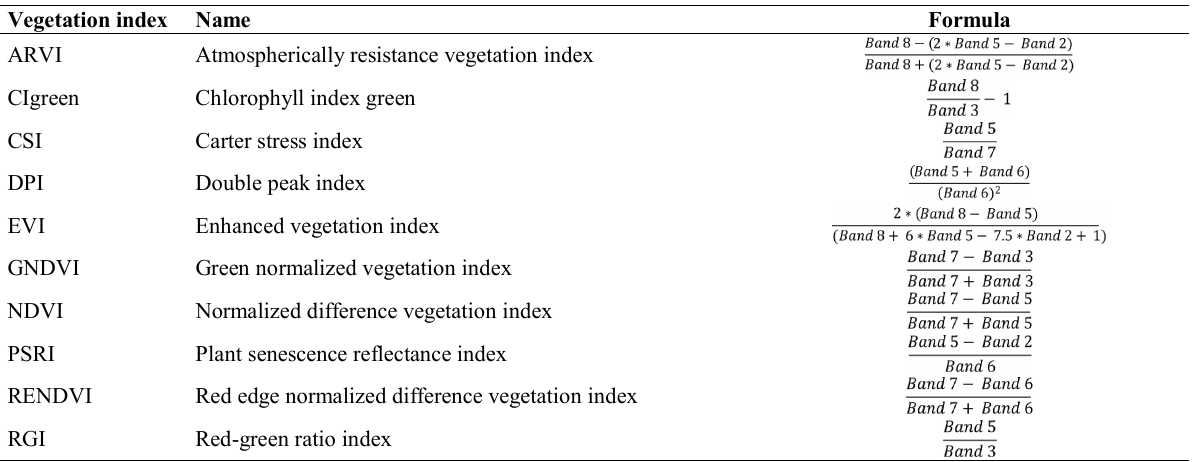
Table 1. Vegetation indices, selected from the literature (Godinho et al., 2018, 2016; Navarro-Cerrillo et al.,